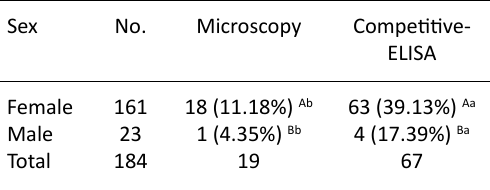
Table 4. Association of positive A. marginale infections to age factor Age No. Microscopy Competitive- <1year 38 6 (15.79%) Ca